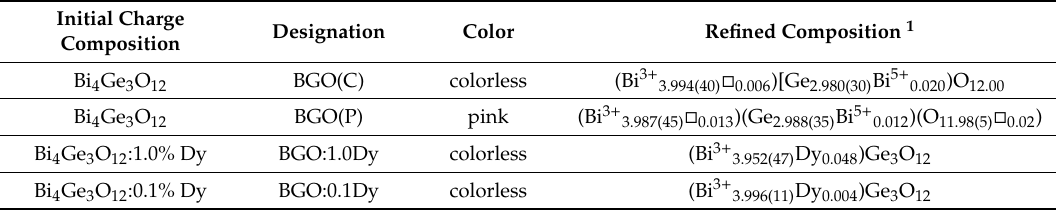
(Table 8). The pink color of the BGO(P) crystals is due to the color center (V O on oxygen vacancies) due to the reducing growth atmosphere. It should be noted that the similar change in the color of garnet Gd 3 Ga 5 O 12 crystal from colorless to pink was also caused by the presence of a color F- center (V O •• ,2e (cid:48) ) × [153]. Table 8. Refined compositions of the BGO and BGO:Dy crystals according to single-crystal X-ray di ff raction (XRD)